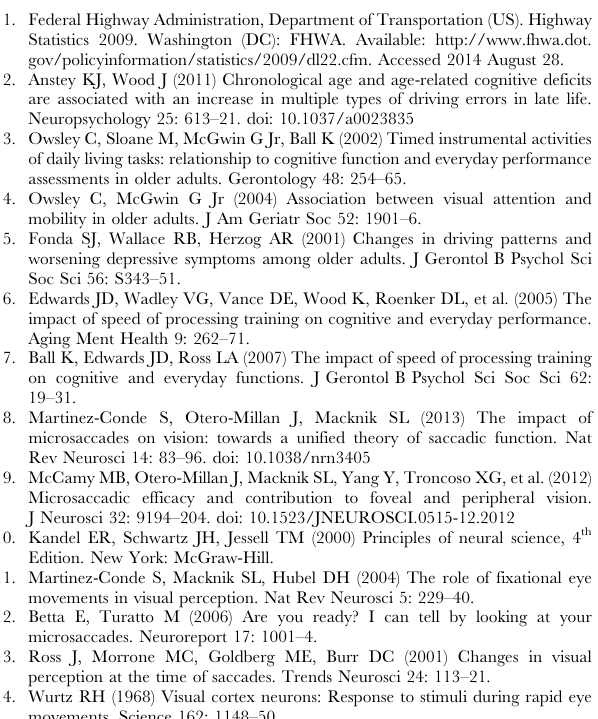
Figure S1 Comparison of Training Groups for Task